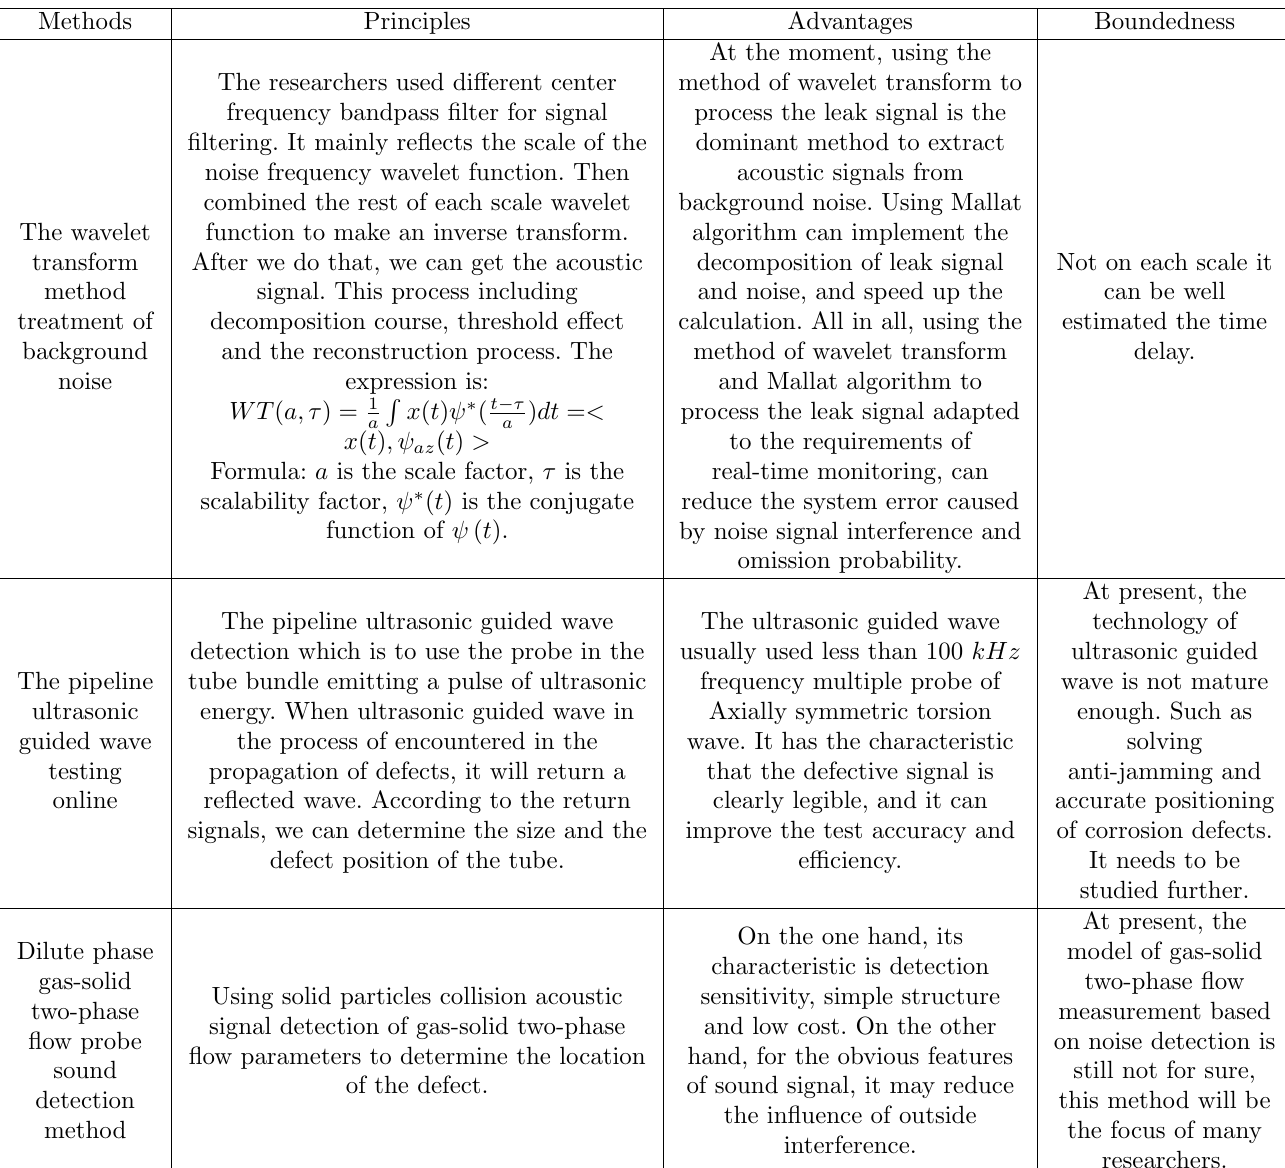
Table 5. The different sound detection methods for heat exchanger